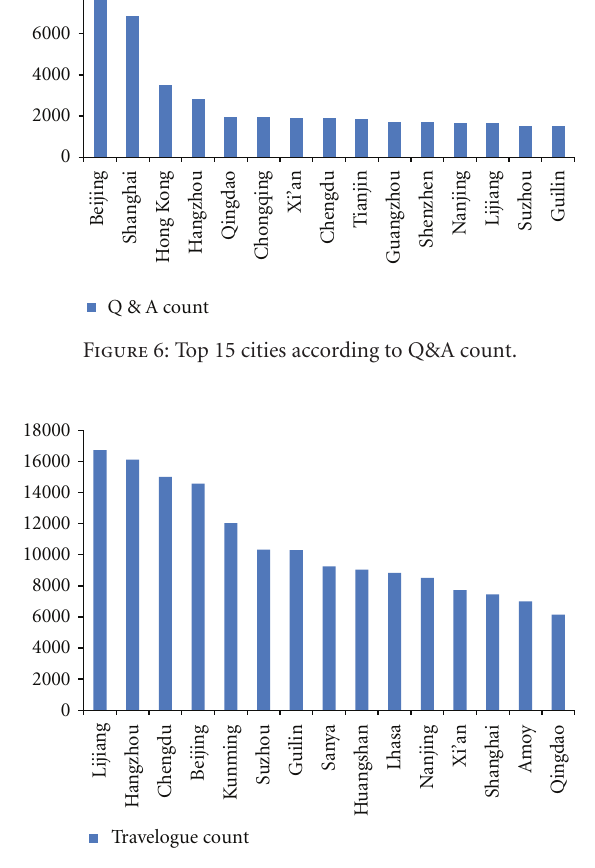
Figure 7: Top 15 cities according to travelogue